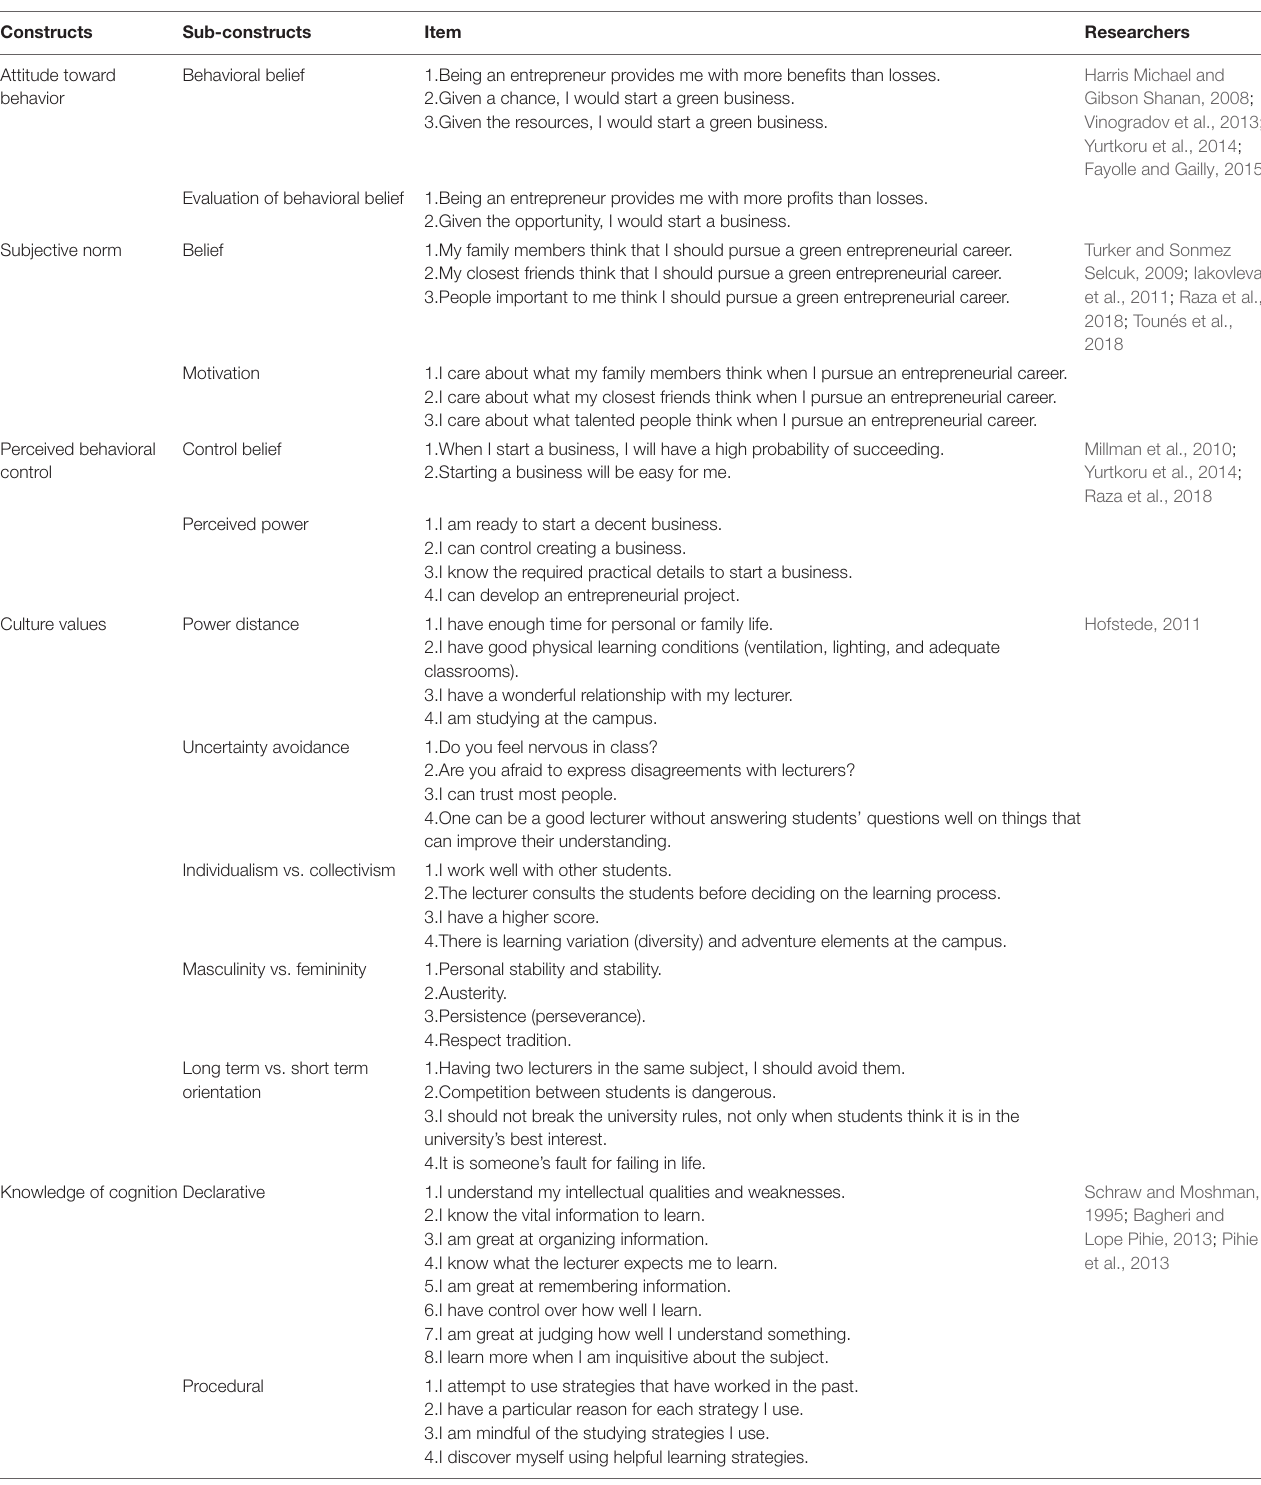
TABLE 1 | Measurement of constructs.